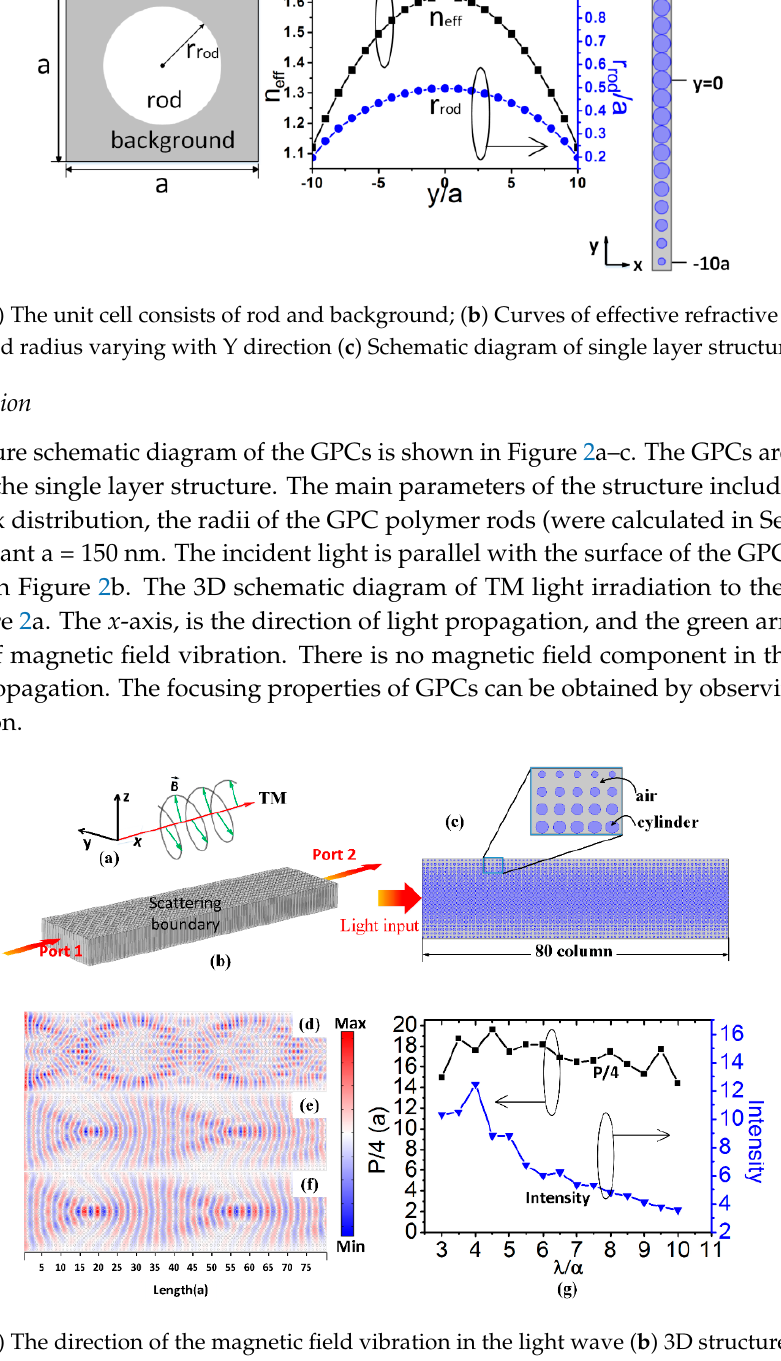
Figure 2. ( a ) The direction of the magnetic field vibration in the light wave ( b ) 3D structure model of the GPCs ( c ) 2D structure model of the GPCs. The electric field distributions at ( d ) λ /a = 3 ( e ) λ /a = 4 and ( f ) λ /a = 5 ( g ). The P/4 and the relative intensity of light at focal point variation with the various of the incident wavelength.